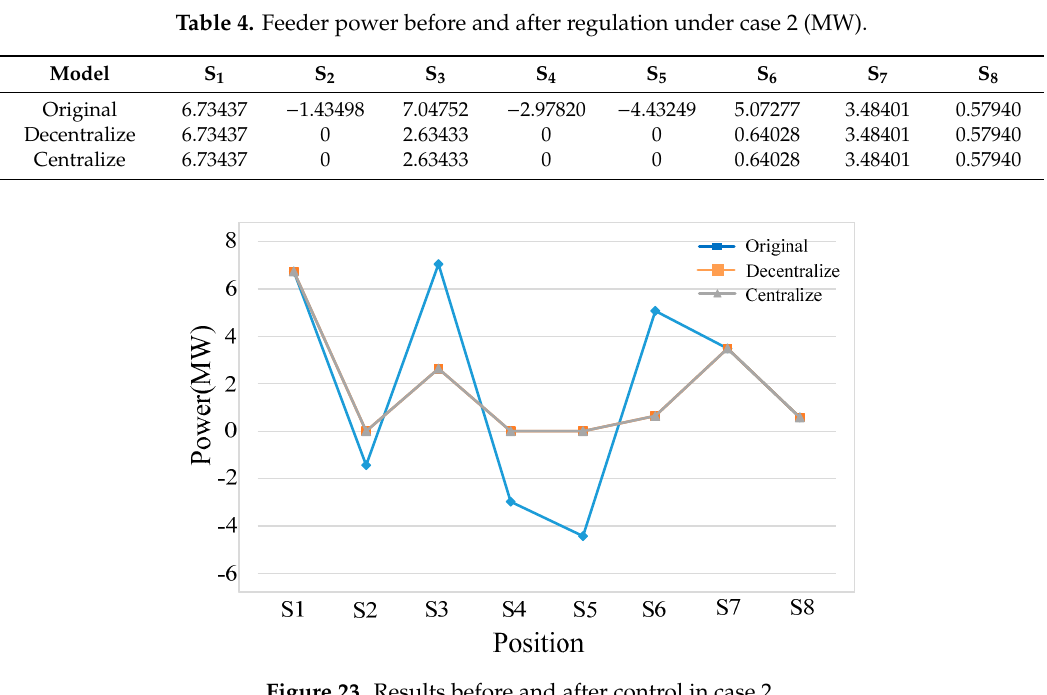
Figure 23. Results before and after control in case 2